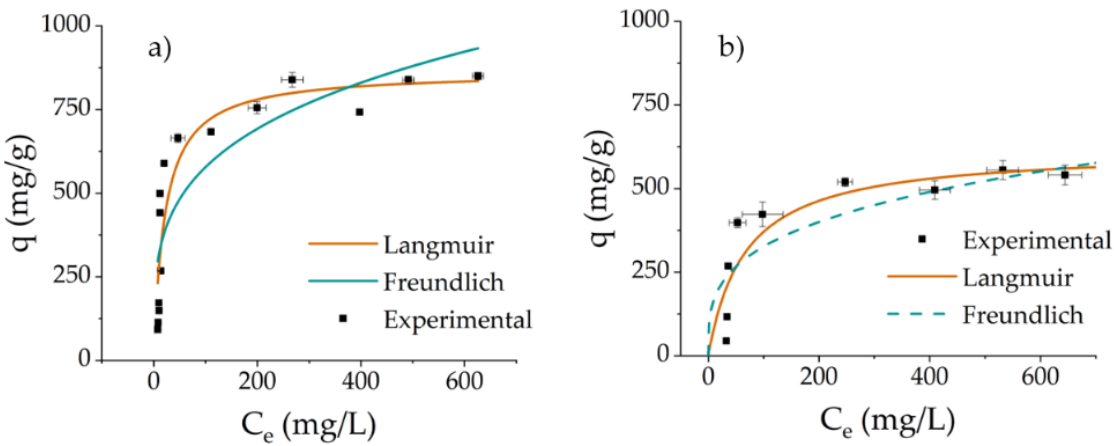
Figure 6. Adsorption isotherm modeling of the adsorption of ( a ) Cyt C and ( b ) Lys onto DCMC. Each value is reported as mean ± SD of triplicate independent experiments.